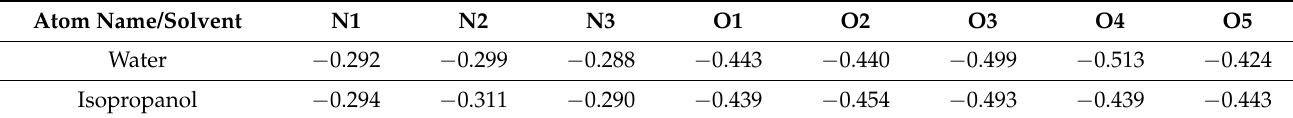
Table 2. Charge states of sorption centers in PI-PAA (in charges of electron,